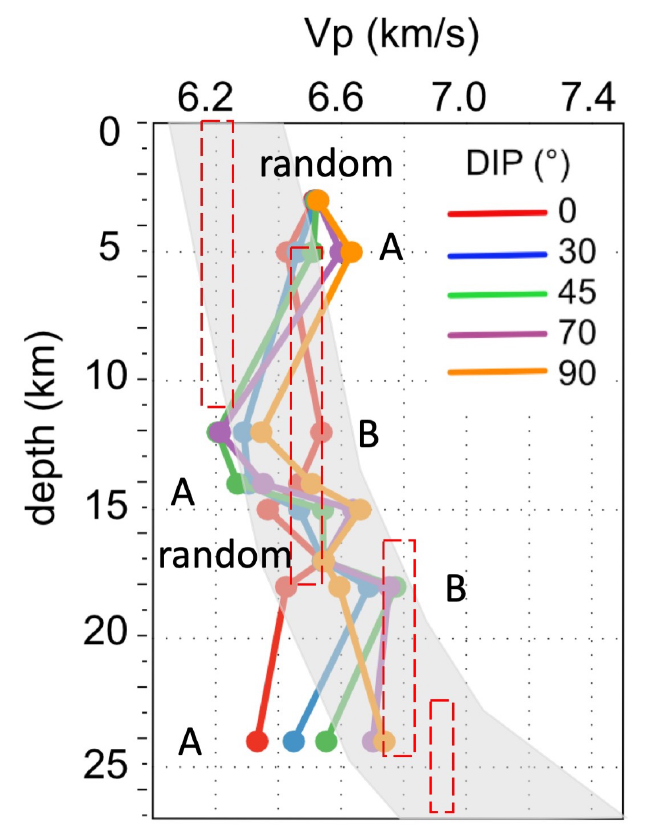
Figure 11. P-wave velocity propagating vertically (T component of Figure 7) crustal profile based on the data presented in this work for carbonate rocks at different depth and dip angle of the shear plane. Greys correspond to the predicted P-wave velocities in the continental crust as modeled by Lloyd et al. (2011) [23]. Vertical red boxes correspond to Vp ranges for middle to lower crust Rudnick & Fountain (1995) [117]. Random, A and B texture Types described in the